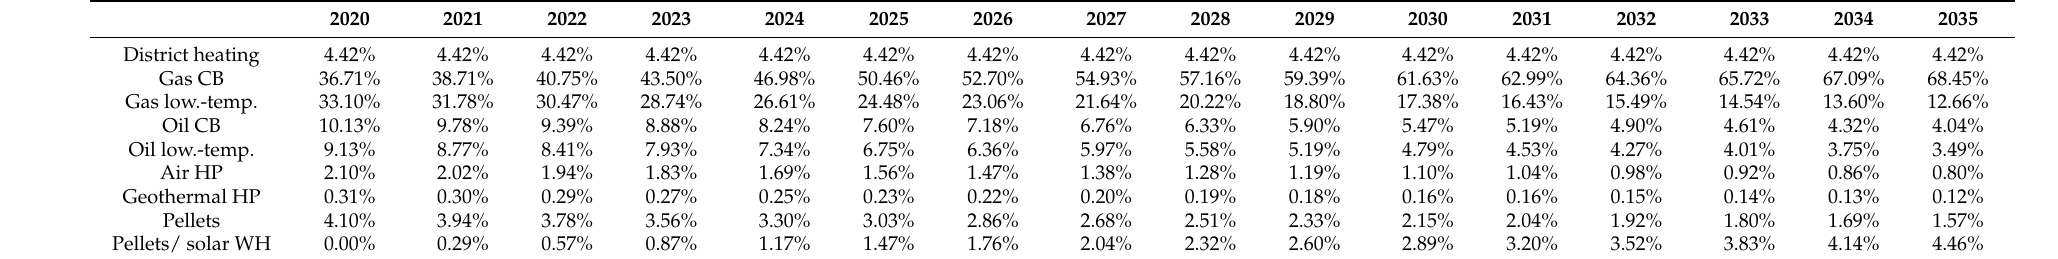
Table A1. Share of technologies BAU Scenario.